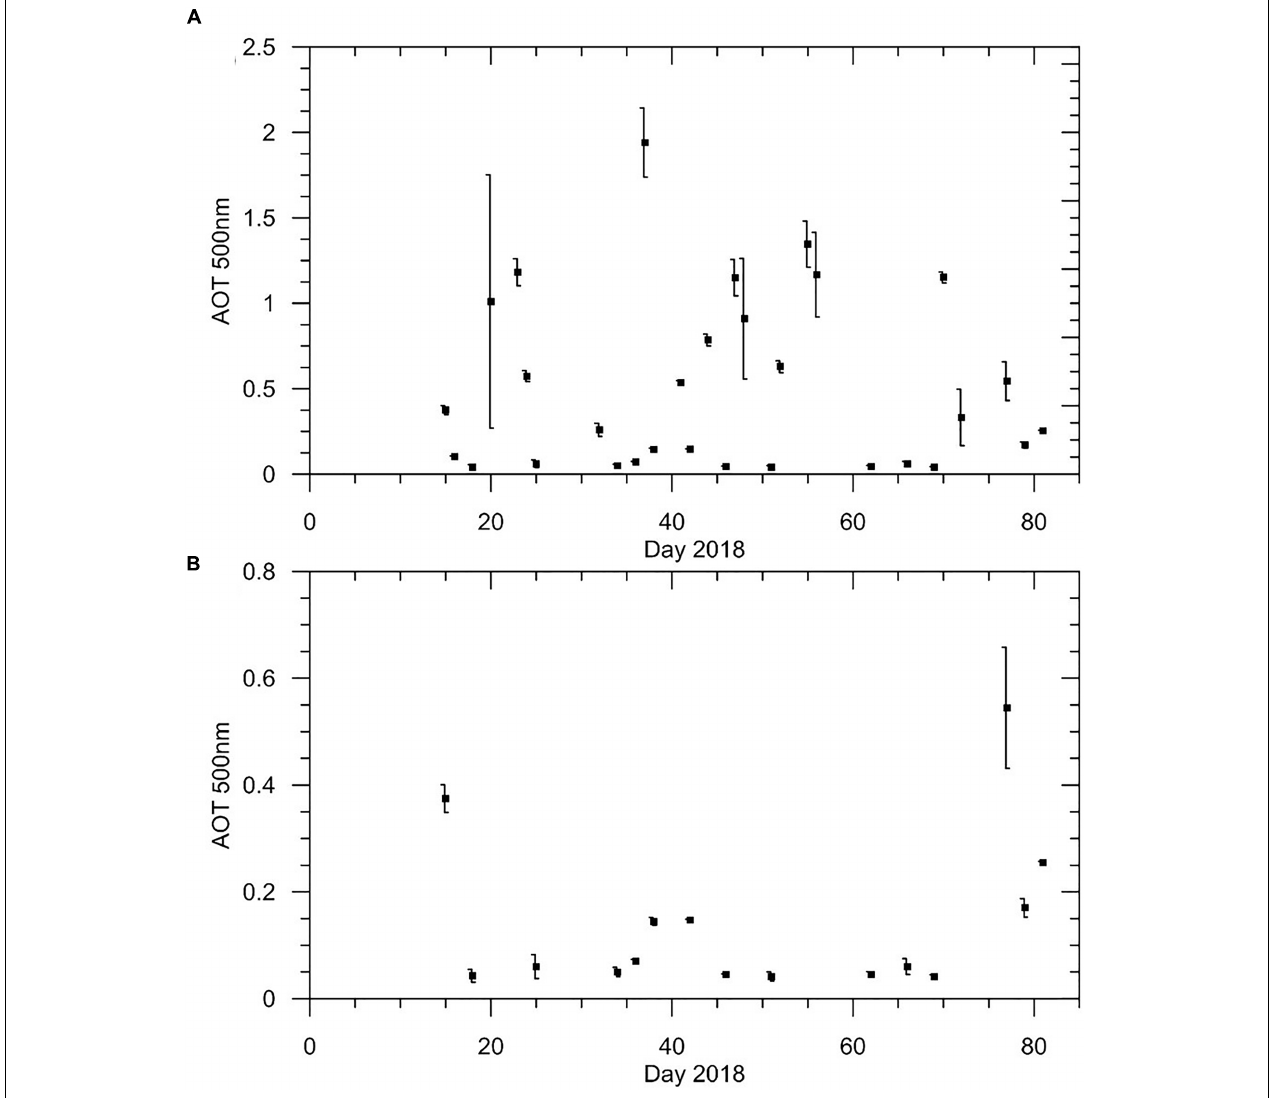
FIGURE 14 | Mean AOT for 500 nm with standard deviation for each day (A) all measurements (B) when water vapor column was ≤ 0.8 cm.